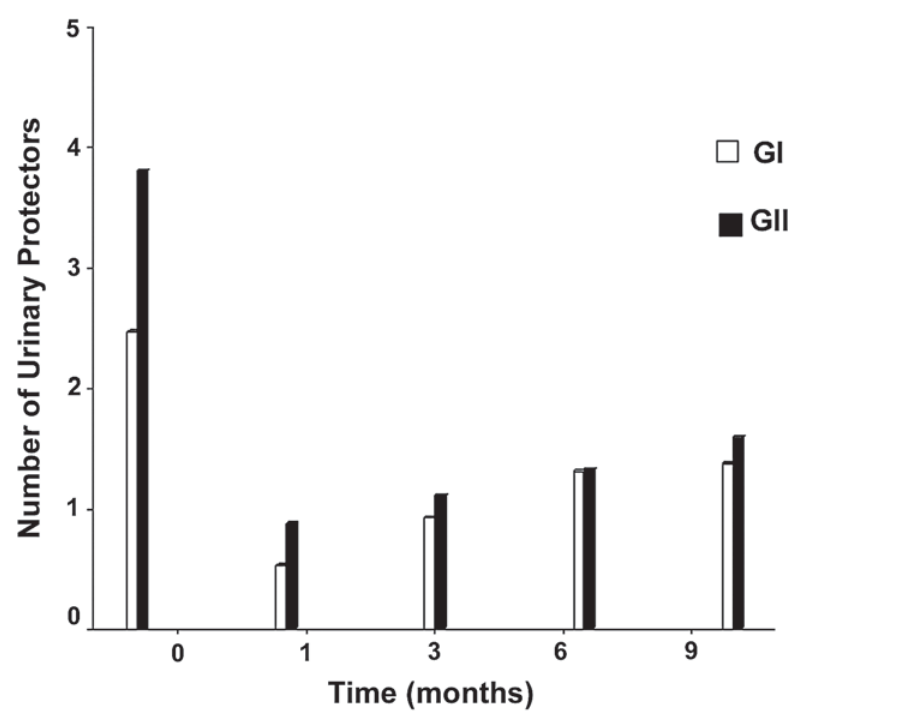
Figure 2 – Number of urinary protectors before and after periurethral injections. Before (GI X GII): Kruskal-Wallis test (p < 0,05) ∴ GII > GI. After - 1, 3, 6 and 9 months: (GI X GII): Kruskal-Wallis test (p > 0.05); 1, 3, 6 and 9 months: (GI X GI): Kruskal-Wallis test (p <